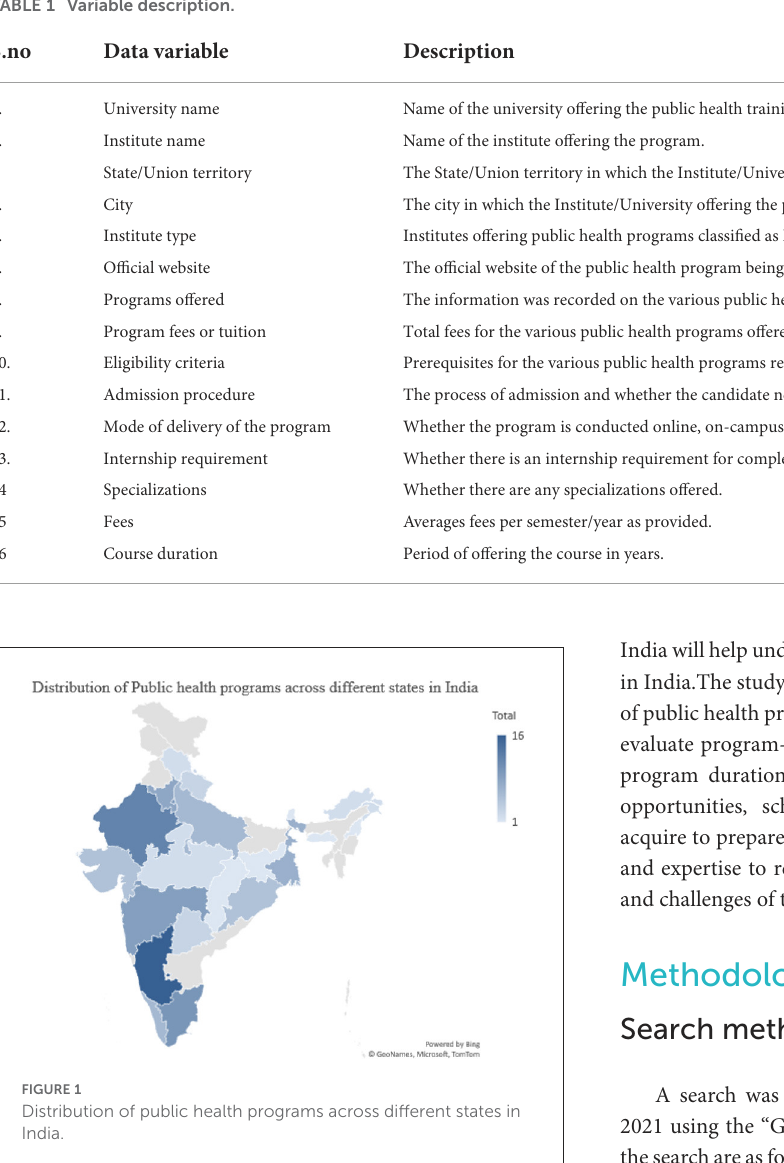
sphere and the need to meet the qualitative demand